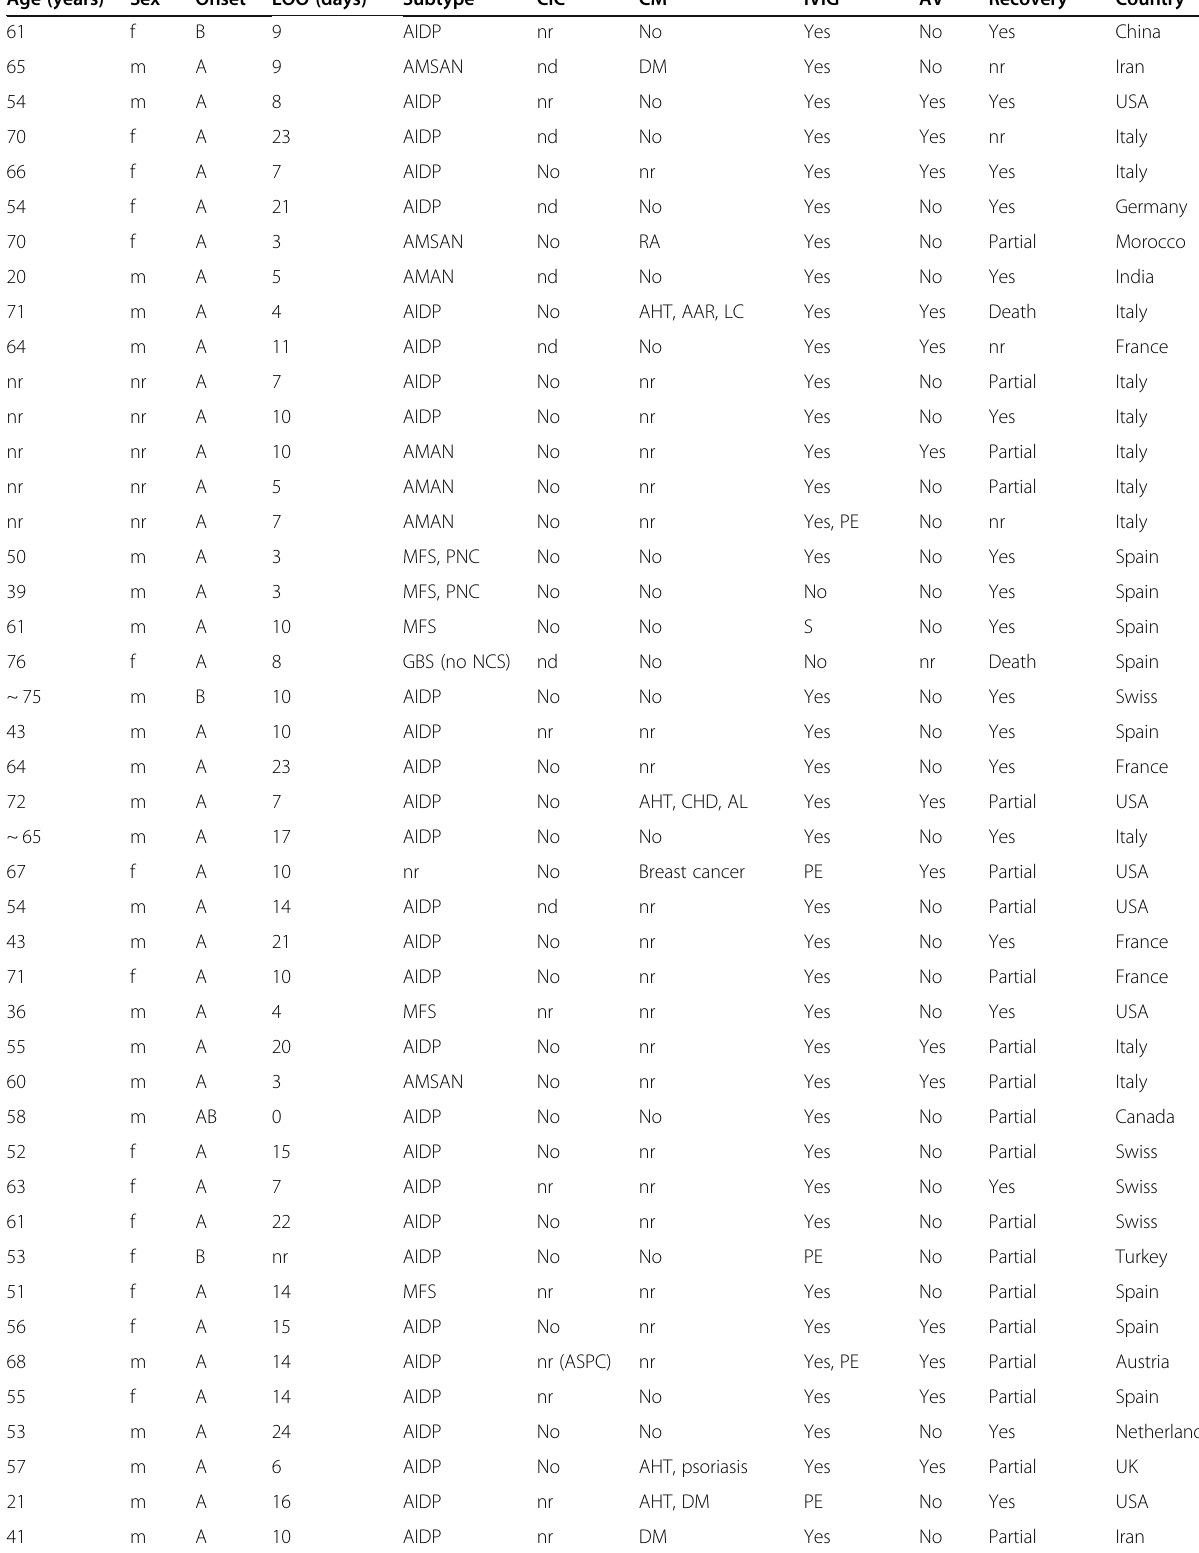
Table 1 Patients with SARS-CoV-2 associated polyradiculitis as reported by the end of December 2020 Age